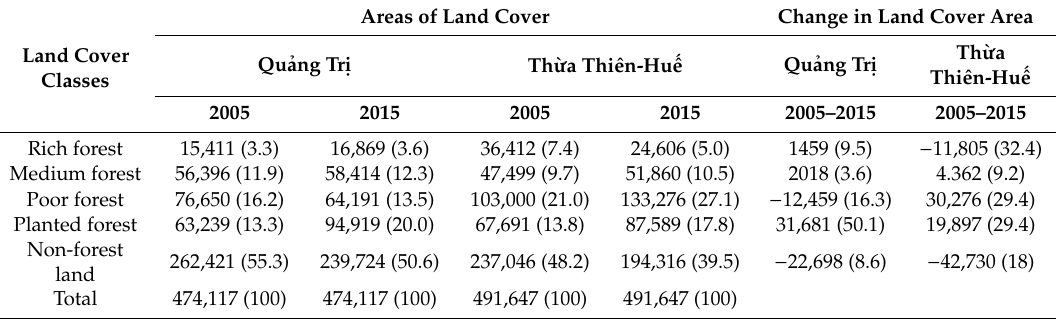
Table 4. Land cover change between 2005–2015 in Qu ả ng Tr ị and Th ừ a Thi ê n-Hu ế Provinces. Unit area is in hectares (ha); the percentage of the area is indicated in the